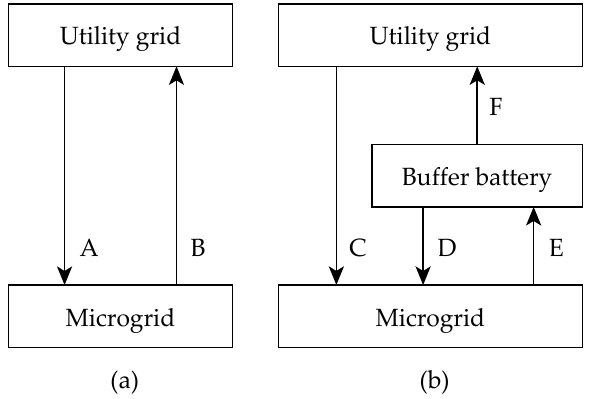
Figure 1. Energy flows between microgrid (MG) and utility grid (UG). ( a ) MG without BB, ( b ) MG with (BB).